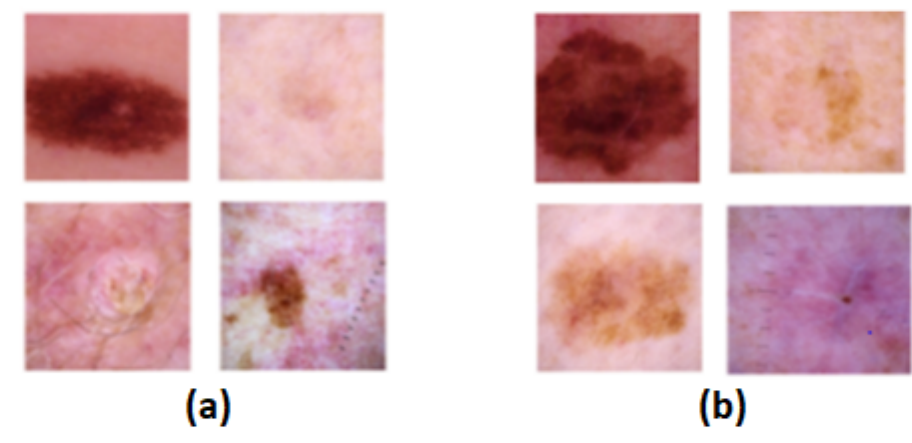
Figure 2. ( a ) Benign and ( b ) melanoma lesions